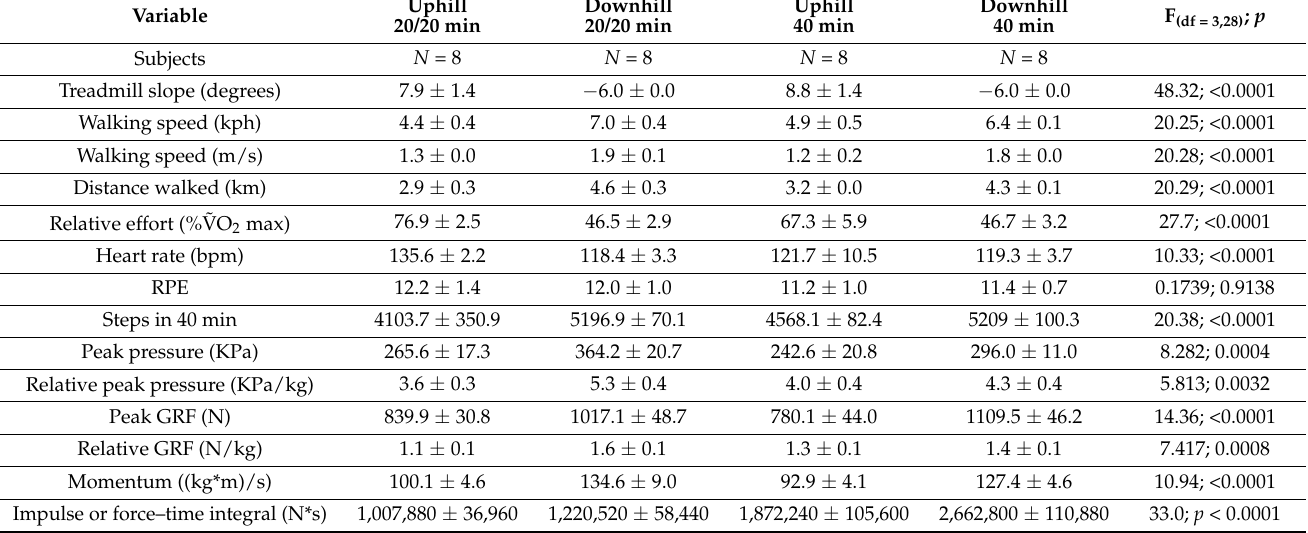
Table 3. Exercise